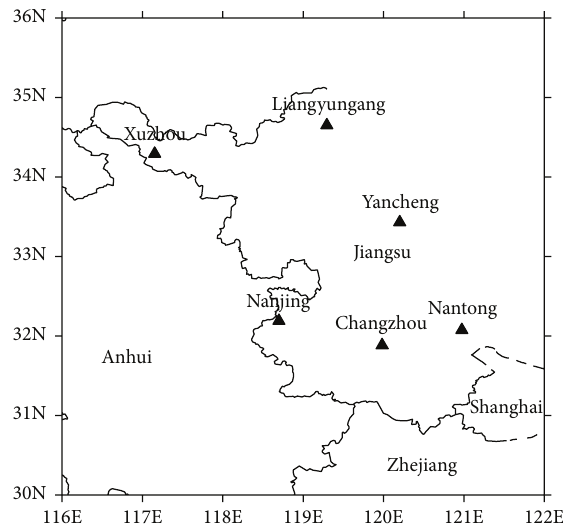
Figure 1: The study domain and locations (as triangles) of Doppler